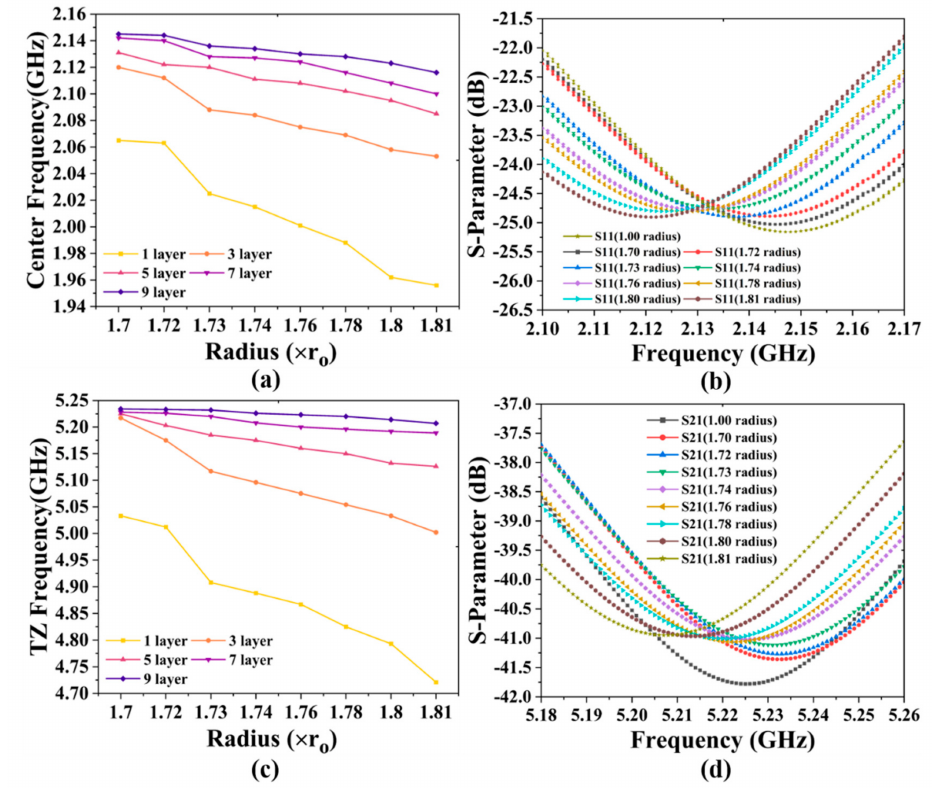
Figure 10. Results of ( a ) center frequency and ( c ) transmission zero frequency based on fine-tuning, as well as specific ( b ) S11-parameter and ( d ) S21-parameter results with 9-layer